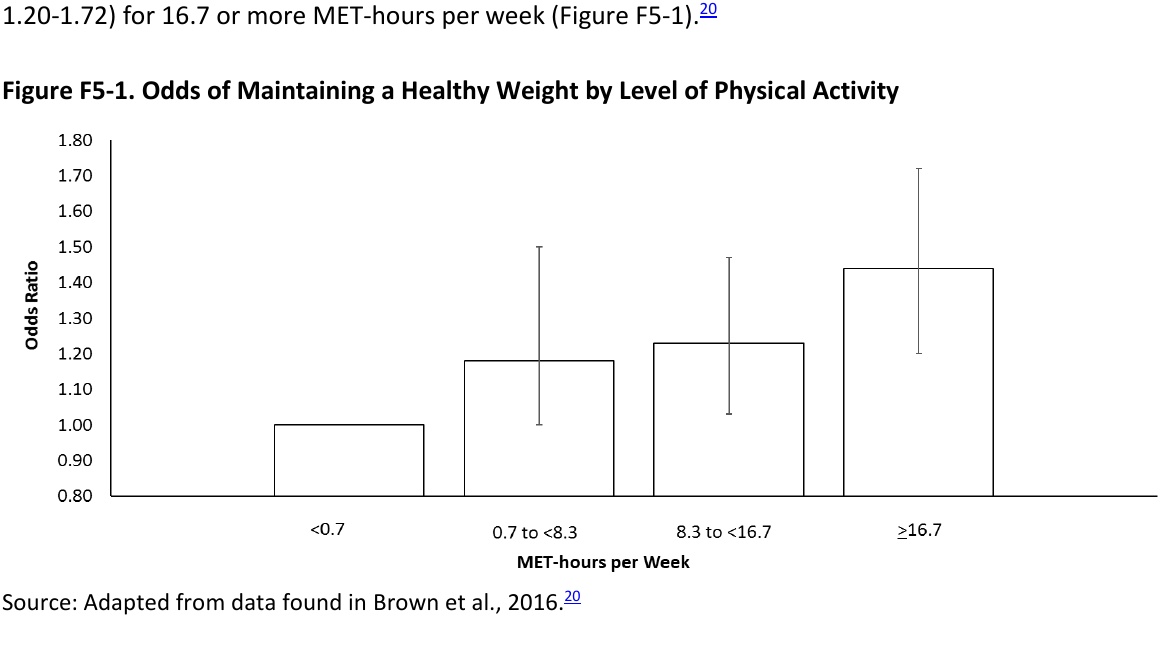
Source: Adapted from data found in Brown et al., 2016.